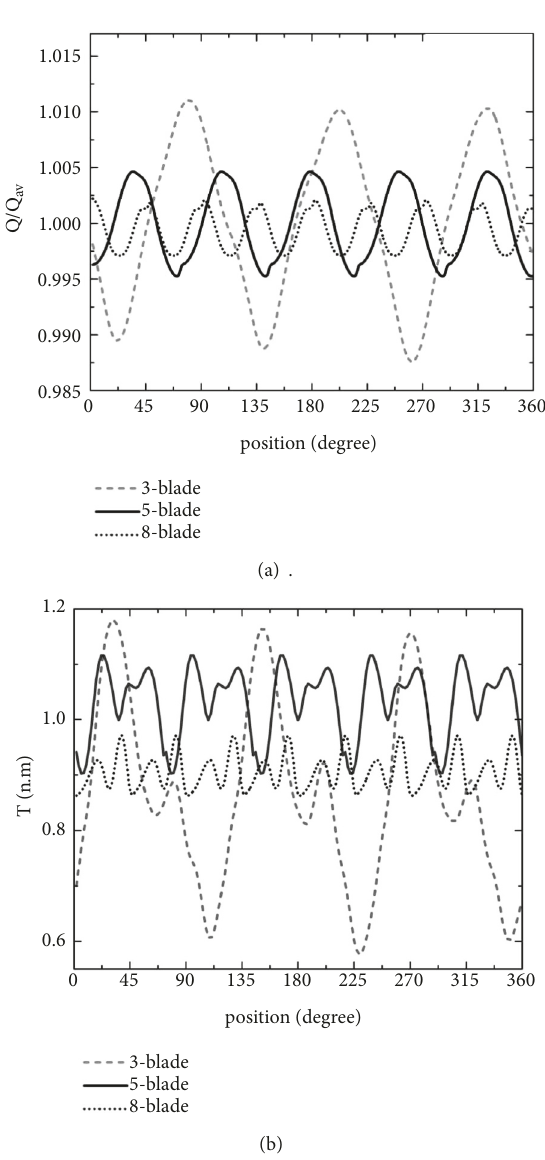
Figure 13: (a) Normalized flow rate and (b) generated torque for one